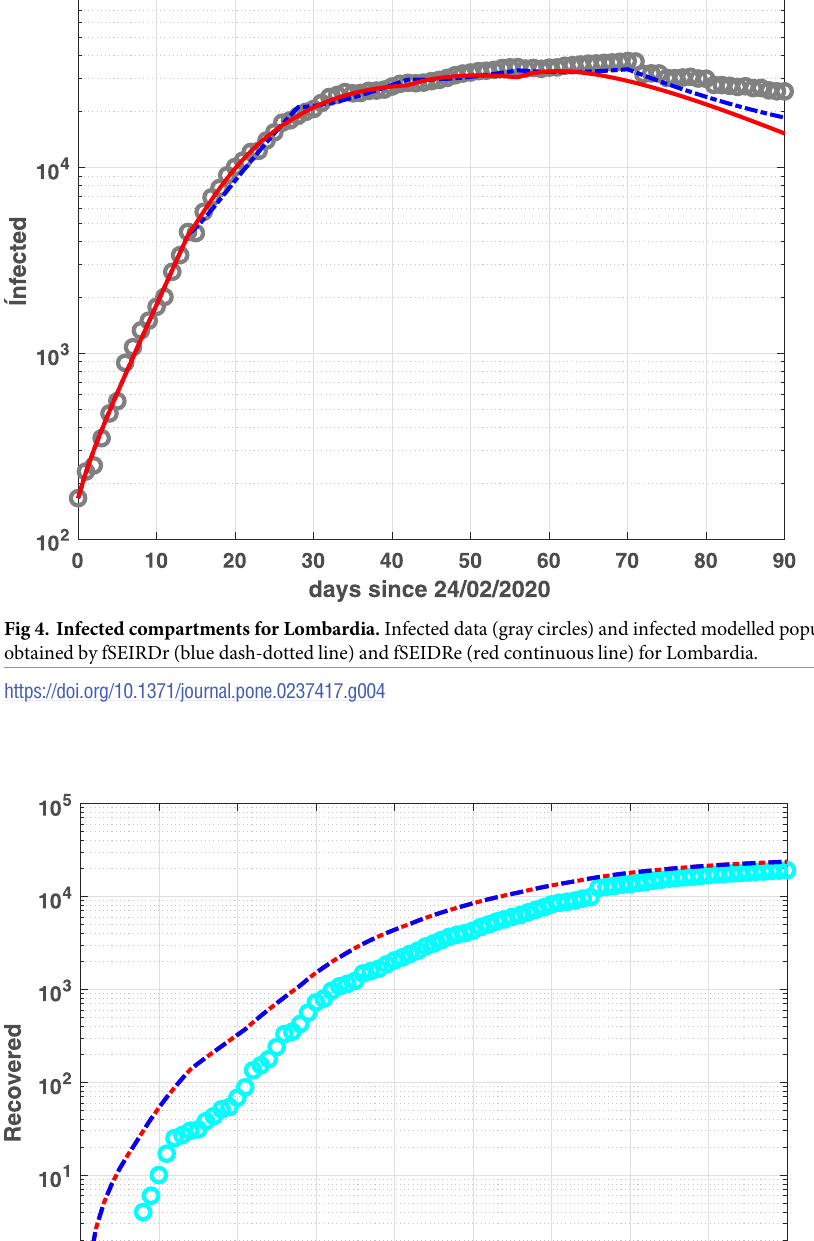
PLOS ONE | https://doi.org/10.1371/journal.pone.0237417 August 6,